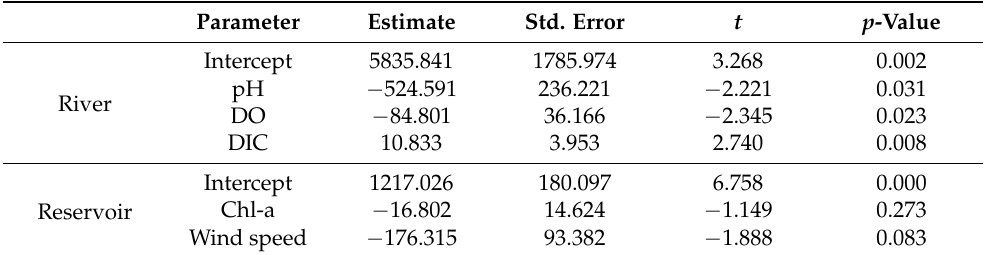
Table 1. Parameter estimates for the best model developed for explaining the pCO 2 in the rivers (R 2 = 0.37) and reservoirs (R 2 =